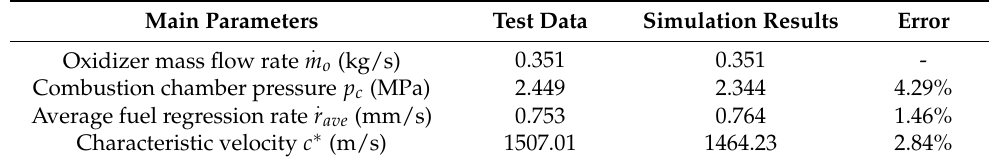
Table 4. Comparison between simulation results and test data.